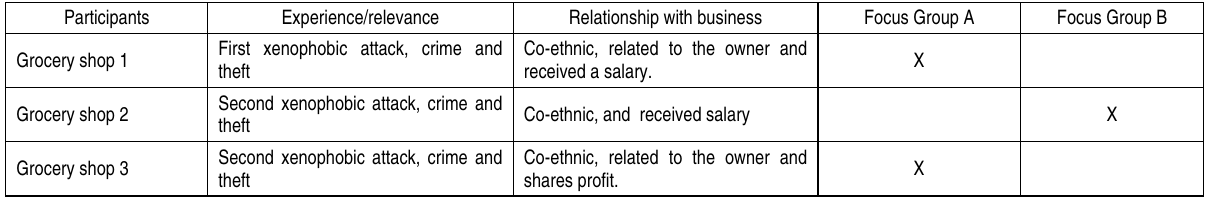
Table 1. Background data of the grocery shop